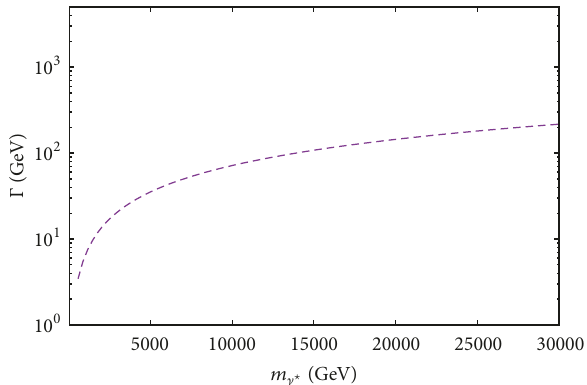
Figure 2: The total decay widths of the excited neutrino for the scale Λ = 𝑚 𝑓 = 𝑓 󸀠 = 1 . ] ⋆ and the coupling